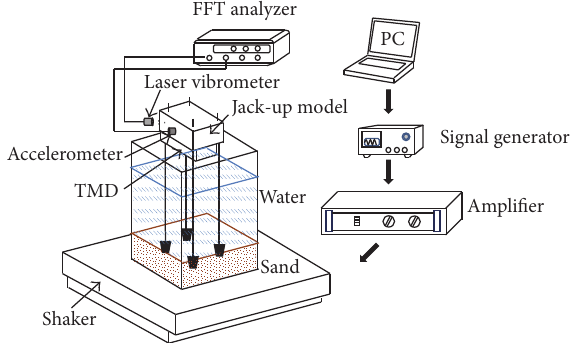
Figure 8: Diagram of the testing system (PC: personal computer, TMD: bufferable tuned-mass damper, and FFT Analyser: fast Fourier transform